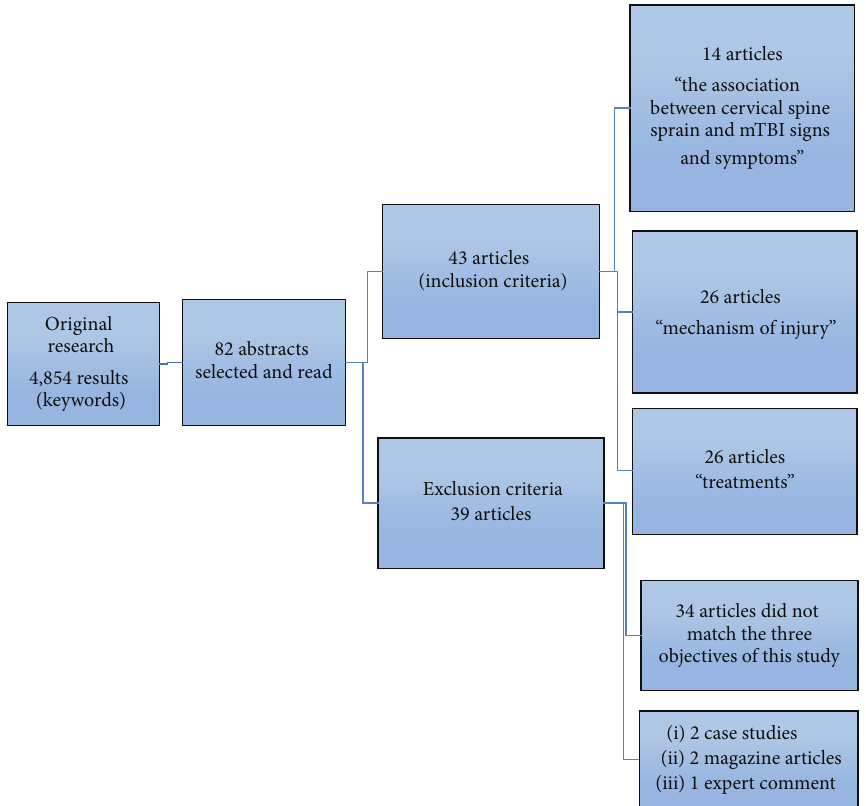
Figure 1: Research method for this